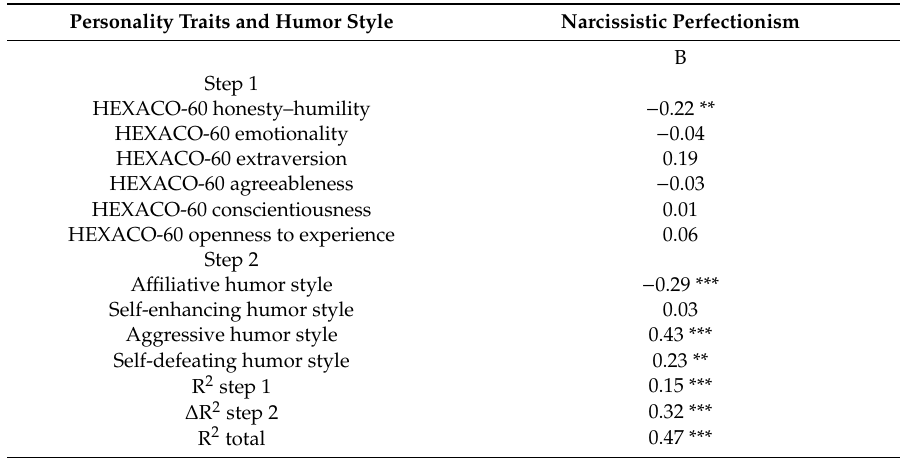
Table 4. The contributions of personality traits HEXACO-60 (first step) and Humor Styles (second step) to narcissistic